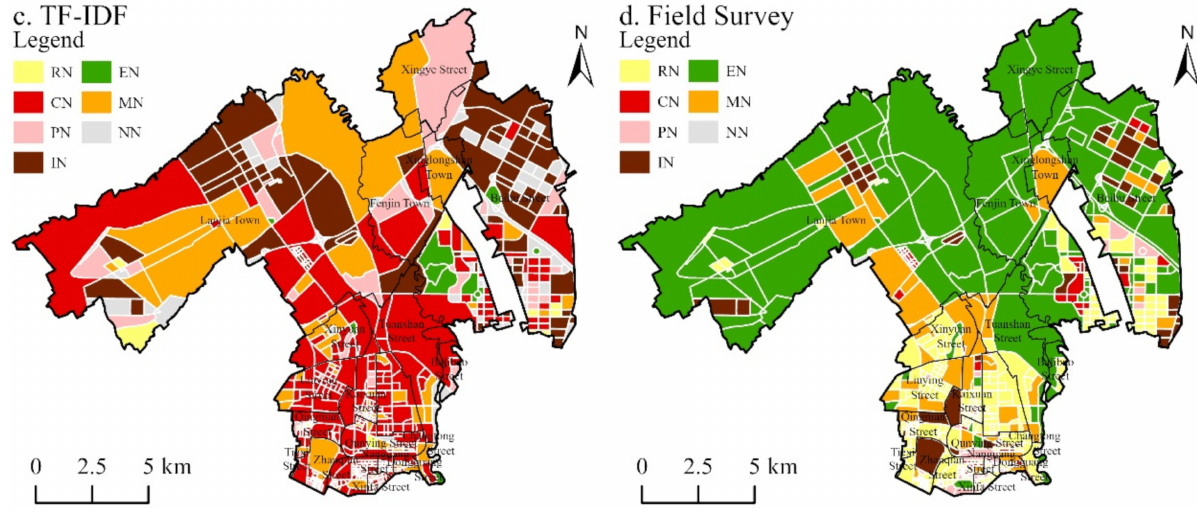
Figure 8. Spatial distribution of the prediction results of ( a ) KDE, ( b ) TF-IDF, and ( c ) UDL, with ( d ) field surveys.